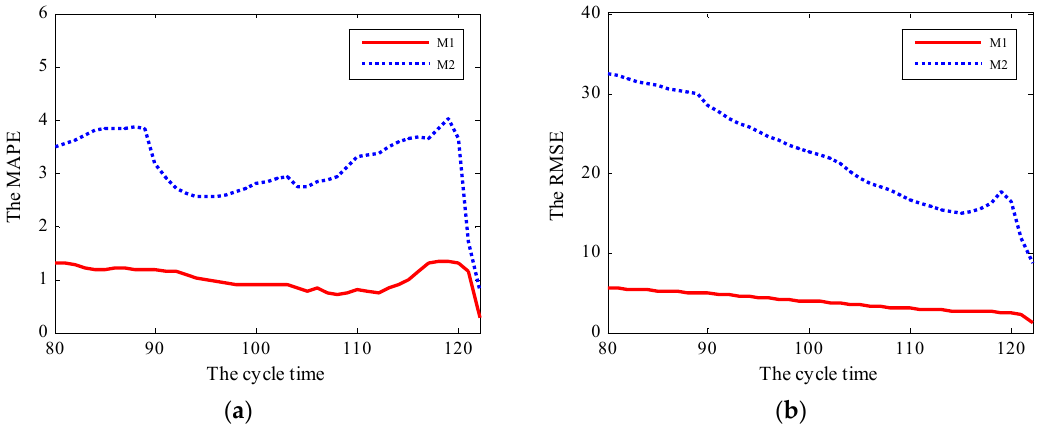
Figure 10. The results of MAPE and RMSE at some time points: ( a ) The MAPE by M1 and M2; and ( b ) the RMSE by M1 and M2.